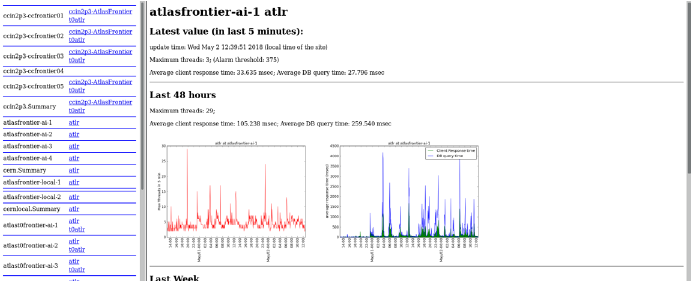
Figure 3. Kibana Dashboard: distribution of time-demanding queries grouped by task ID’s (top) and Fontier servers (bottom)